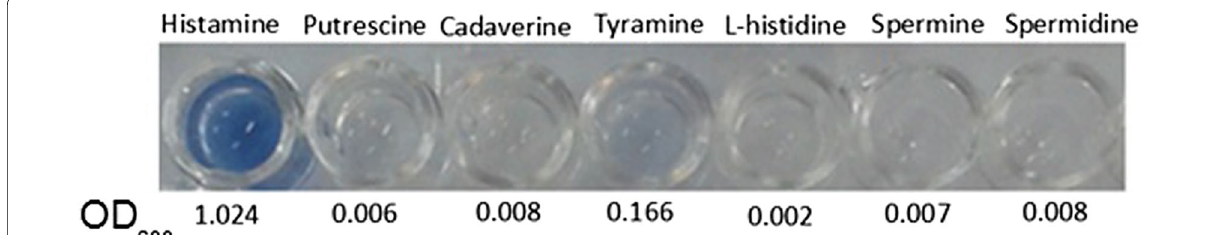
Fig. 4 Substrate specificity of Glutamicibacter sp. N1A3101 HOD against several BAs (absorbance at 600 nm) indicated its high specificity for histamine